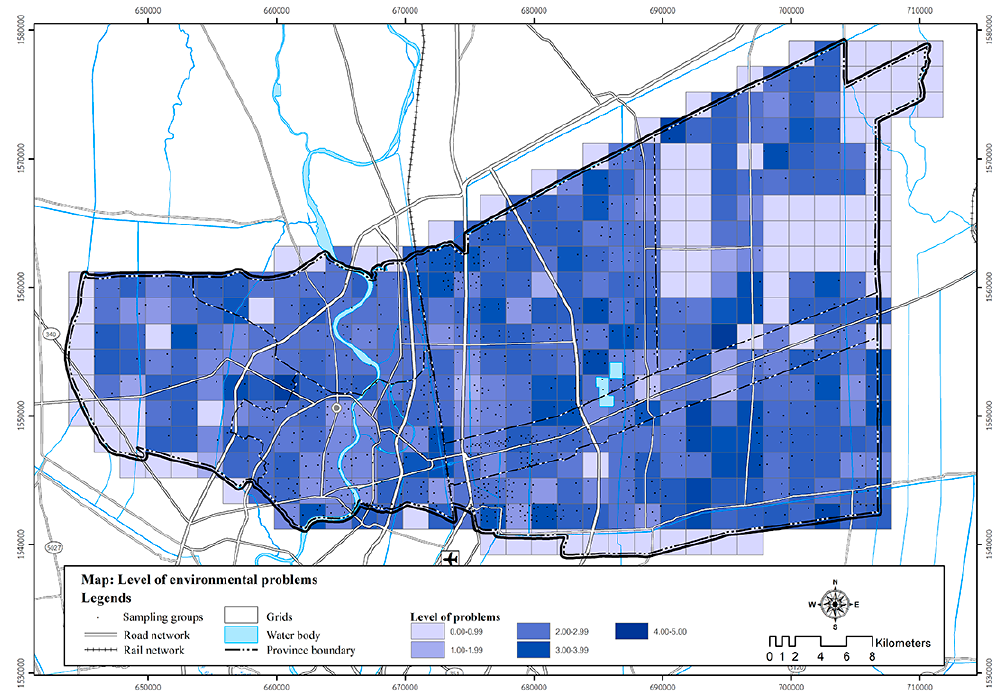
Figure 3. Summary of average score of overall built environment classified by grids